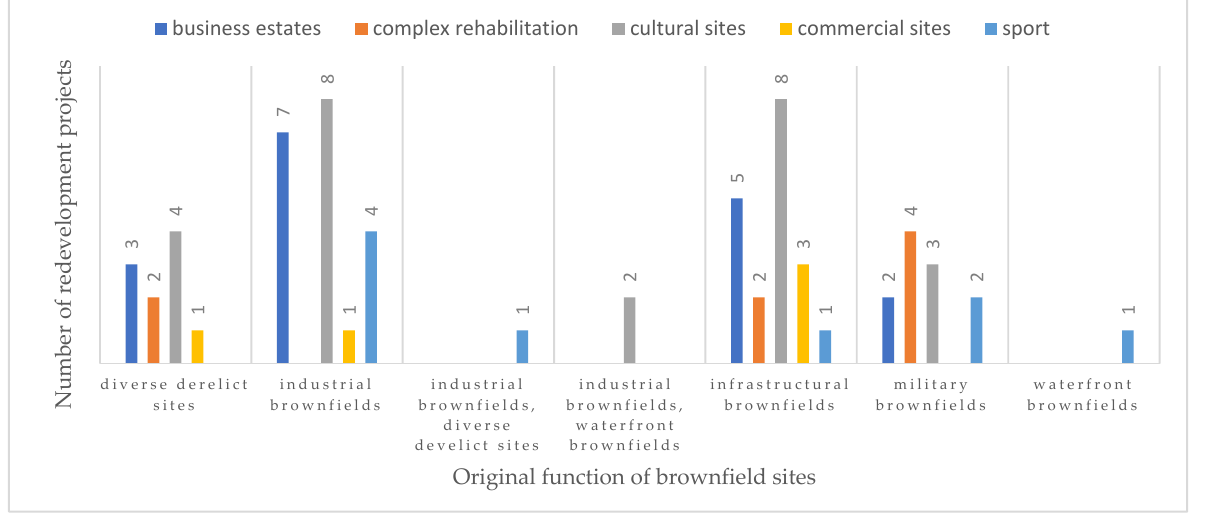
Figure 1. Total redevelopment projects with new functions per original functions (N = 64).